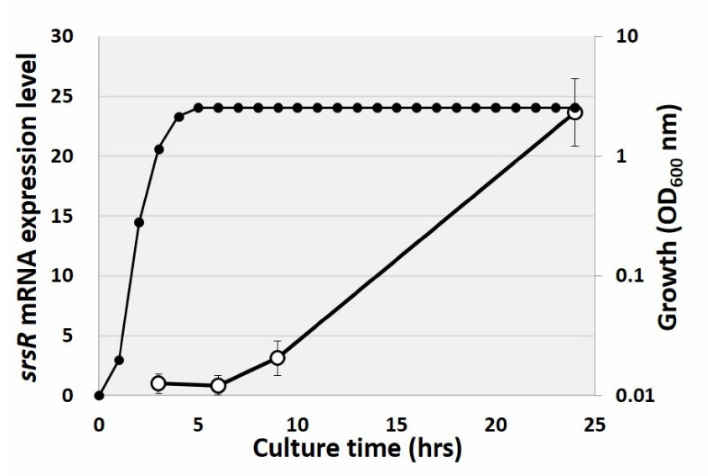
Figure 4. Changing of srsR mRNA level in growth curve. Total RNA was purified from the E. coli wild-type strain at 3, 6, 9, and 24 h of cultivation, and the cell growth was measured by OD 600 nm every 1 h (closed symbol). The srsR mRNA level was compared by setting the ratio against 16S rRNA as an internal control (open